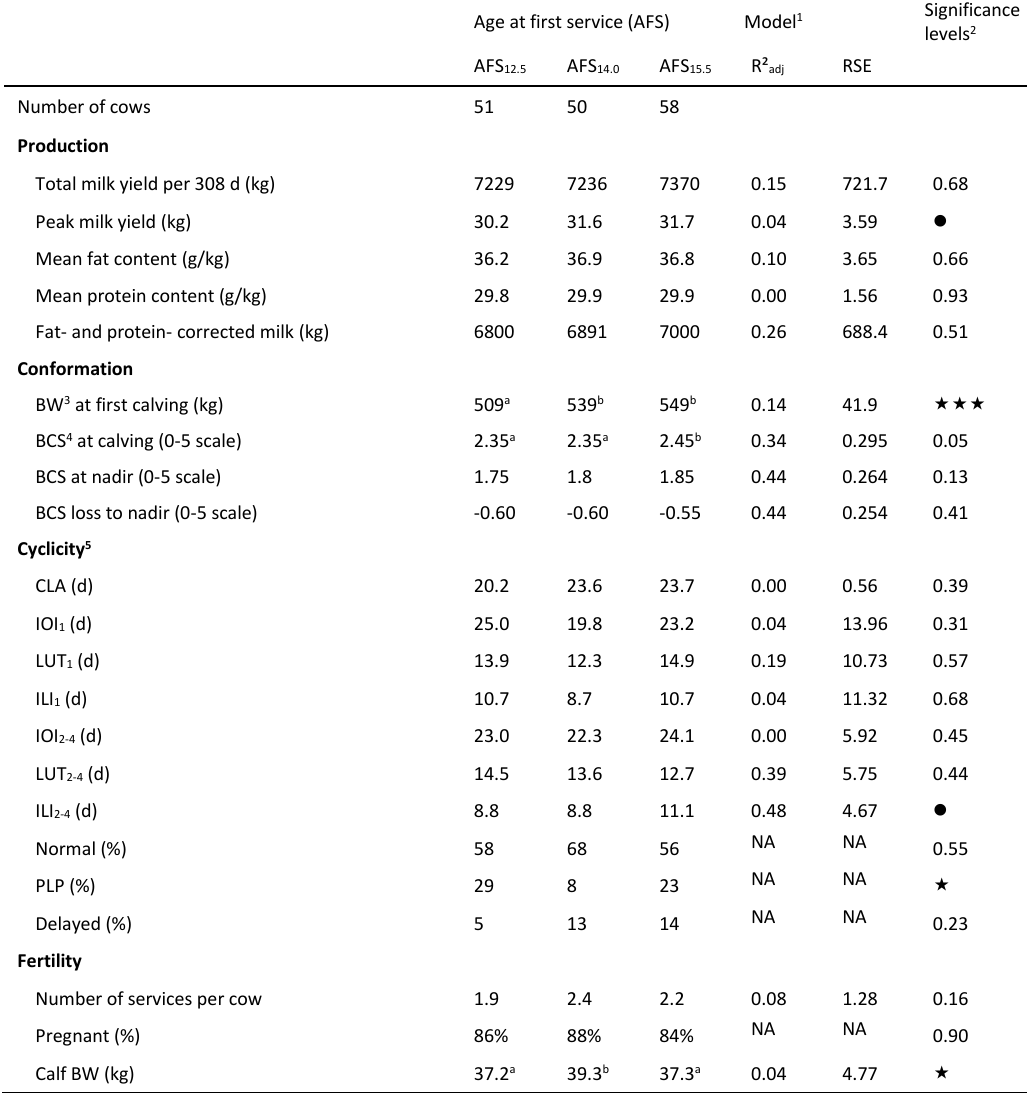
Table 6. Effects of the class of age at first service (AFS) on the productive and